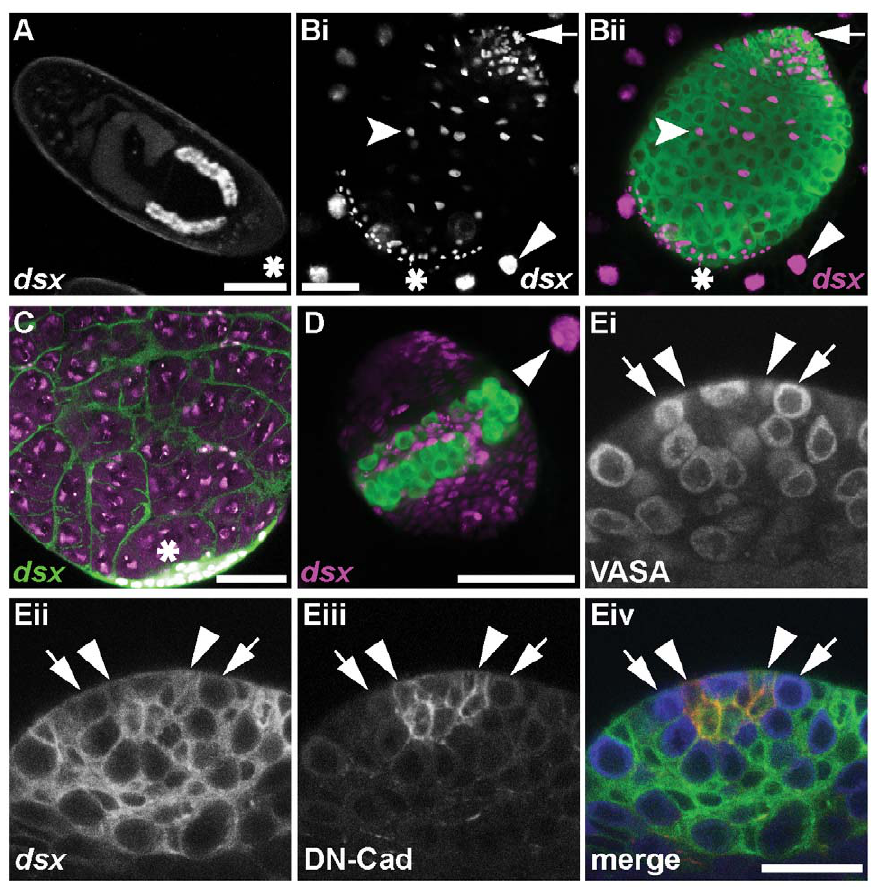
Figure 2. dsx GAL4 driving UAS-induced fluorescent reporters recapitulates known patterns of gonadal dsx expression. (A) dsx GAL4 expression is restricted to cells of the paired uncoalesced gonads in embryonic stage 13. The embryo posterior is marked by an asterisk, and native GFP fluorescence was imaged from the membrane reporter, UAS-mCD8::GFP . Scale bar, 100 m m. (B–C) Expression of dsx GAL4 in the male third instar larval gonad is restricted to somatic cells. Reporter is UAS-RedStinger (nuclear DsRed). (Bi) dsx GAL4 -expressing cells include the clustered hub cells of the stem cell niche at the gonad apical tip (arrow), cyst cells dispersed throughout the gonad (barbed arrowhead), and terminal epithelial cells with small round nuclei at the basal end of the gonad (asterisk). A fat body cell nucleus is indicated (arrowhead). (Bii) dsx GAL4 expression (magenta) is excluded from the germline cells marked with cytoplasmic VASA (green). Scale bar, 50 m m. (C) Expression of the JFRC-IVSA membrane-bound GFP reporter (green) reveals sheath cell cytoplasmic processes ramifying through cysts of male germ cells in the basal half of the gonad. DNA of the large male germline cells is stained with DAPI (magenta). Gonad posterior indicated with an asterisk. Single confocal section shown. Scale bar, 20 m m. (D) dsx GAL4 expression in the female third instar larval gonad is restricted to somatic cells (magenta) and is excluded from the germline cells marked with cytoplasmic VASA (green). A fat body cell nucleus is indicated (arrowhead). Reporter is UAS-RedStinger (nuclear DsRed). Scale bar, 50 m m. (E) dsx GAL4 expression in hub cells of the stem cell niche at the apical tip of male the gonad was visualized with the JFRC-IVSA membrane-bound GFP reporter (Eii; green in Eiv). Processes of dsx GAL4 -expressing cells enveloped germline cells marked with VASA (Ei; blue in Eiv), including the ring of germline stem cells adjacent to the hub (arrows). Expression in hub cells is confirmed by overlap with DN-Cadherin (DN-Cad) (Eiii; red in Eiv), which marks membranes of the hub cells (arrowheads). Overlap of membrane-bound GFP with DN-Cadherin is yellow in the merge (Eiv). Scale bar, 50 m m.